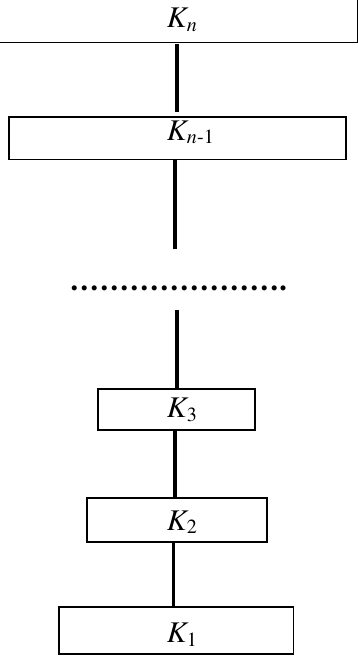
Figure 3. A finite M-space stratification with the cyclic